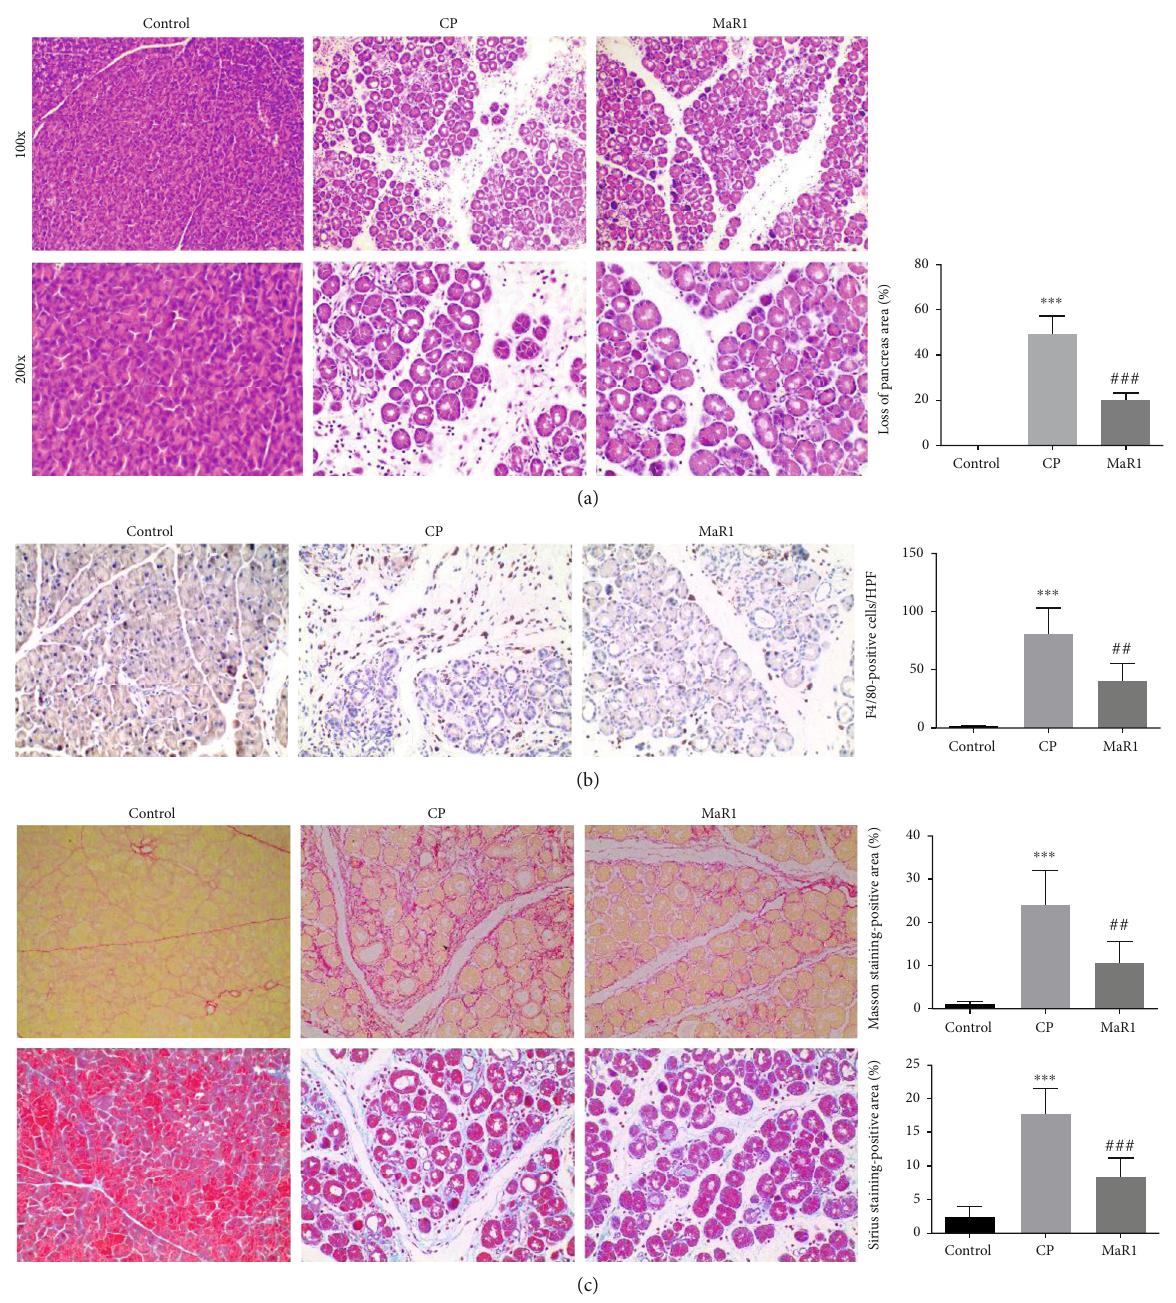
Figure 5: MaR1 alleviated pancreatic tissue injury and fi brosis of pancreatic tissues in CP model. (a) Representative pathological changes in the pancreas after caerulein repetitive injection. HE-stained sections of the pancreas in magni fi cation 100x and 200x and loss of pancreas area was quanti fi ed. (b) IHC examinations and total count for F4/80 of macrophages in the pancreas in magni fi cation 200x. (c) Masson (the upper row) and Sirius red (the lower row) staining for collagen production in the pancreas of mice. n ≥ 10 each group. ∗∗∗ P < 0 : 001 vs. the control group. ## P < 0 : 01 , ### P < 0 : 001 vs. the CP